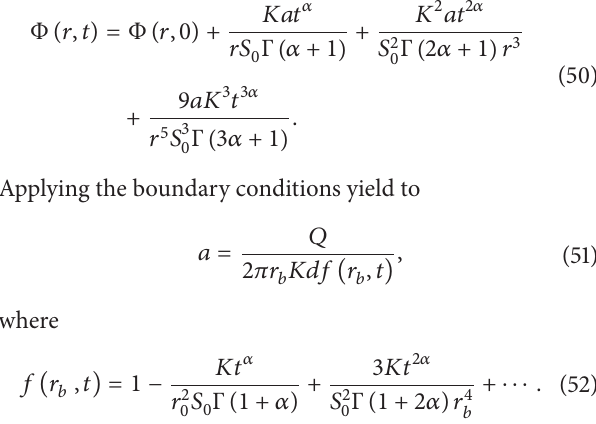
Figure 2: Solution of (30) (piezometric